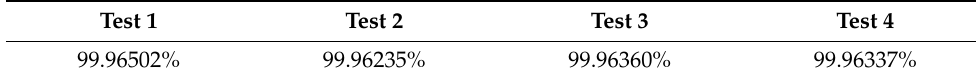
Table 6. Efficiency 2 : Results from four tests for the graph